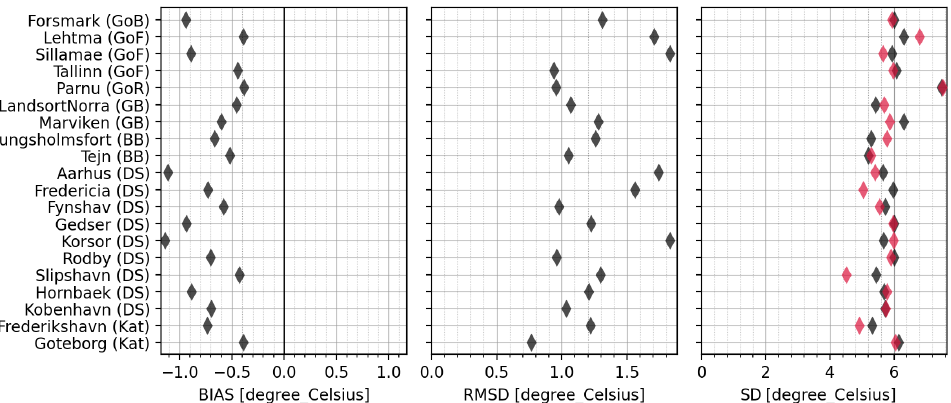
Figure 4. Surface temperature error metrics. Black and red symbols denote the model and observations, respectively. See Fig. 1 for station locations; the sub-basin abbreviations are as in Fig. 2.